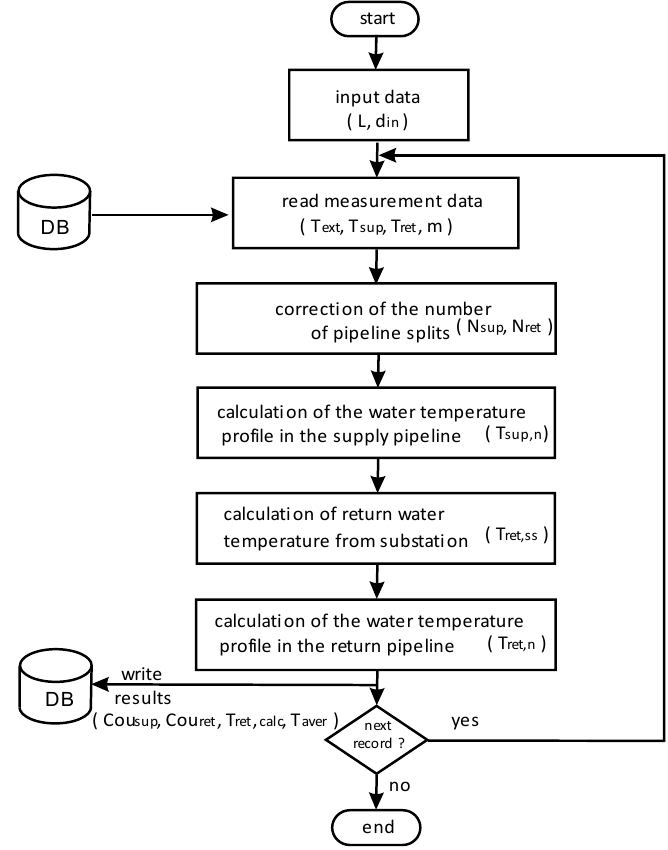
Figure 6. The flowchart of the calculation procedure.